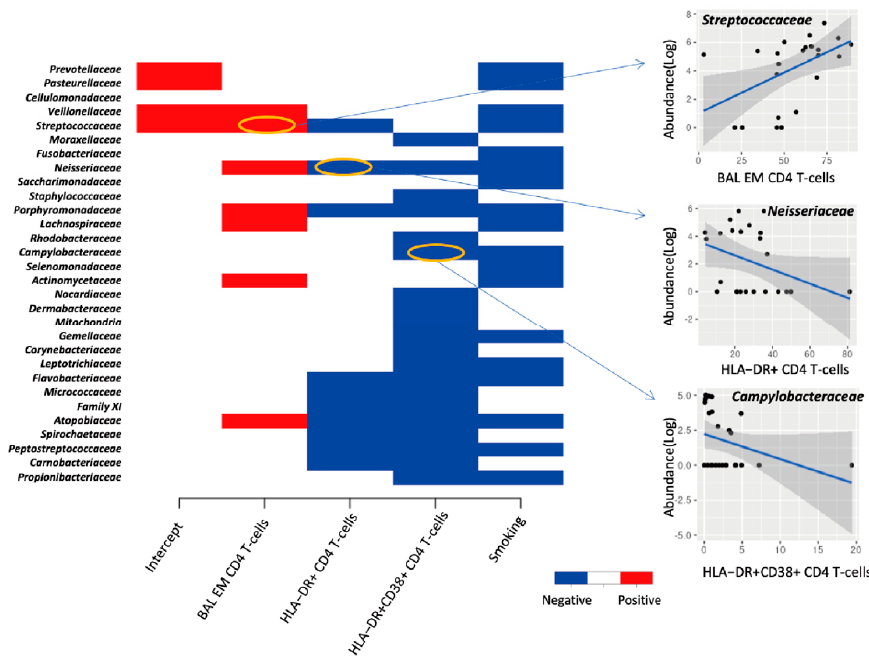
Figure 4. Effect of coefficients of the immune activation markers on the abundance of lung bacterial families. Each row represents a bacterial family, and the column represents the immune activation variables. A significant correlation supported by at least 95% posterior probability was depicted in either blue or red. Specifically, we presented three bacterial families as examples to show the correlation between bacterial abundance and immune activation variables.